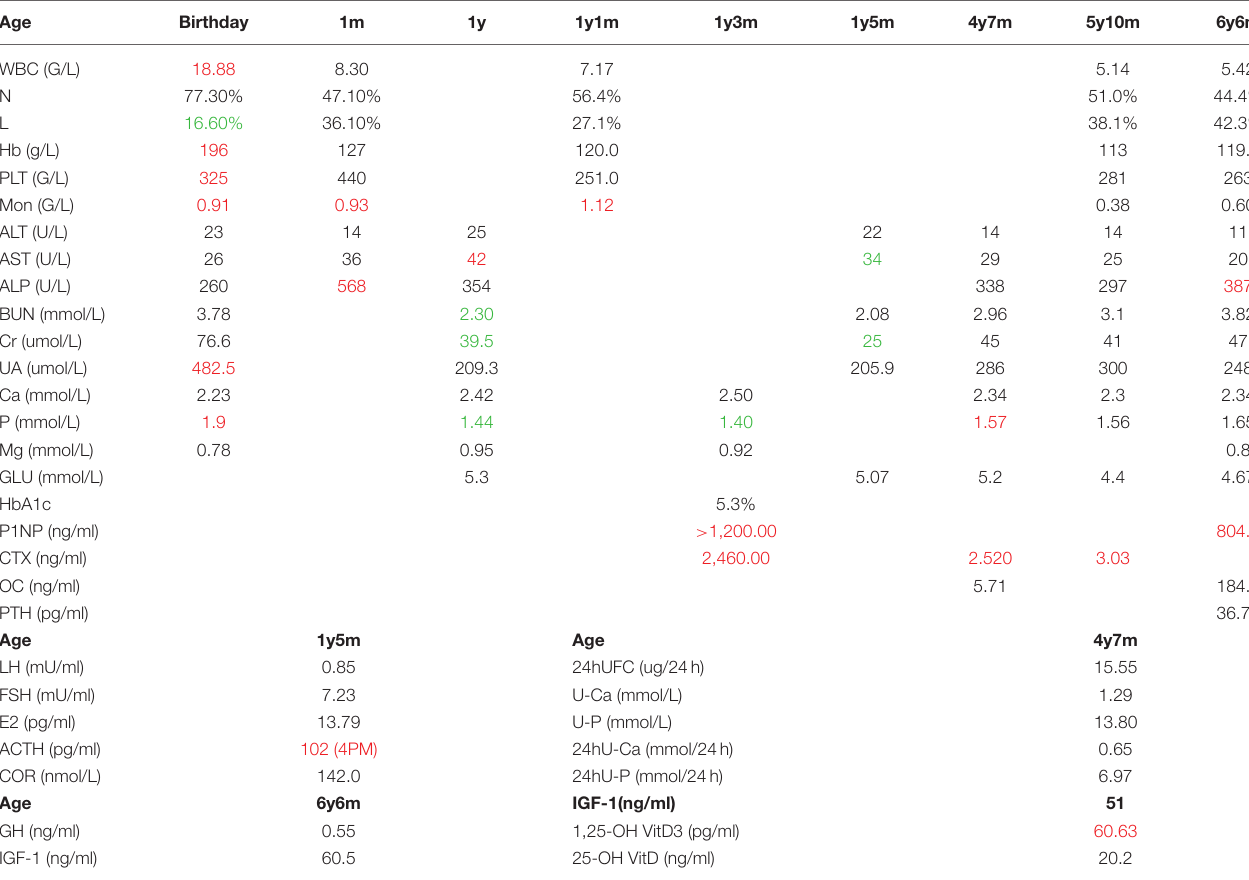
TABLE 1 | The results of laboratory